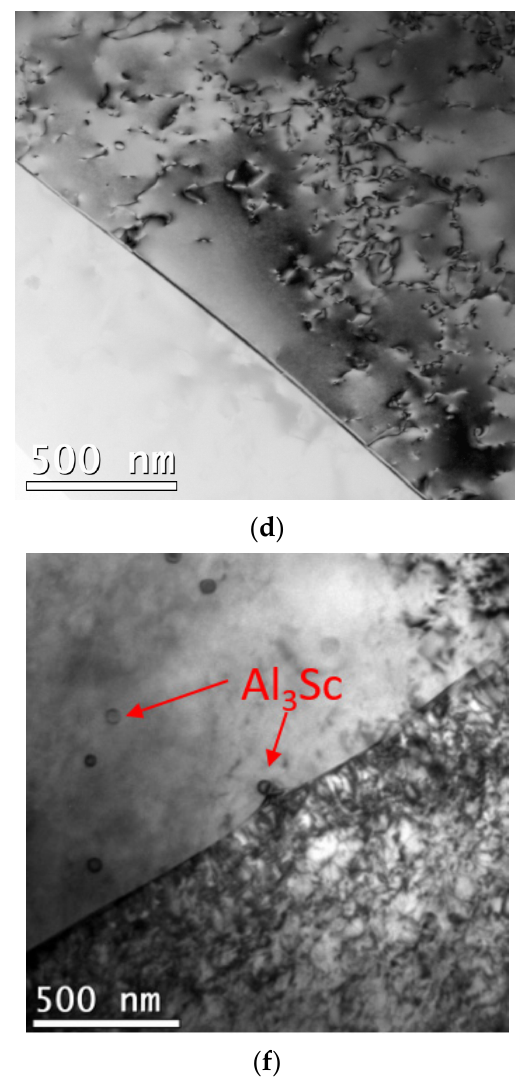
Figure 5. TEM images of the alloys under different annealing processes: ( a ) alloy A(0.1Mn) annealed at 350 °C; ( b ) Al 6 MN mesophase of alloy A(0.1Mn) annealed at 450 °C (EDS analysis: Al: 70.0 wt% Mn: 30.4 wt% Mg: 1.1 wt%); ( c ) alloy B(0.1Zr) annealed at 350 °C; ( d ) alloy B(0.1Zr) annealed at 450 °C; ( e ) alloy C(0.05Sc) annealed at 350 °C; ( f ) alloy C(0.05Sc) annealed at 450 °C.